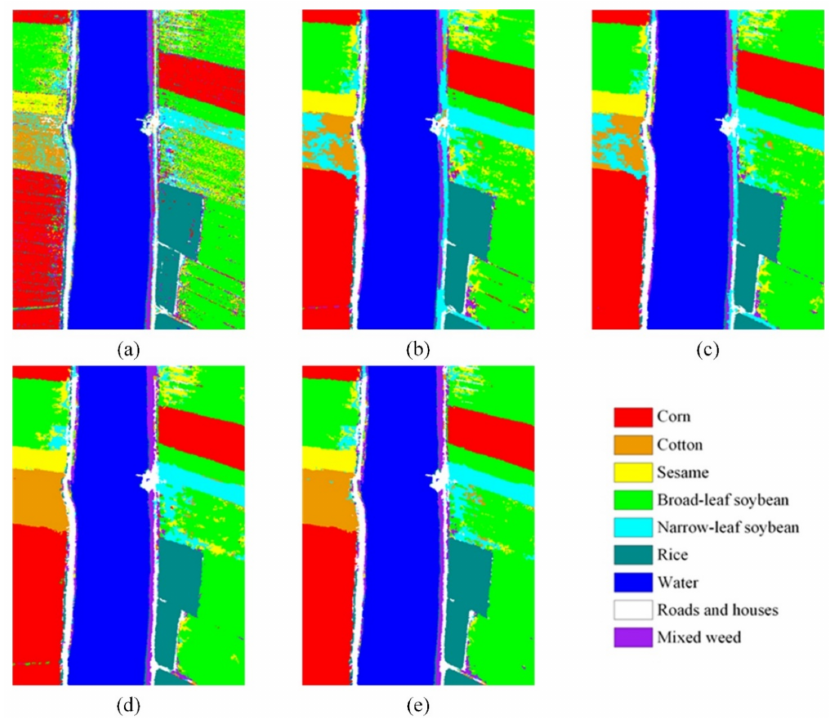
Figure 14. The classification results for the Longkou dataset using RF: ( a ) Pixel-wise spectral classifi- cation; ( b ) MLF; ( c ) MPF; ( d ) MLV; ( e ) MPV.